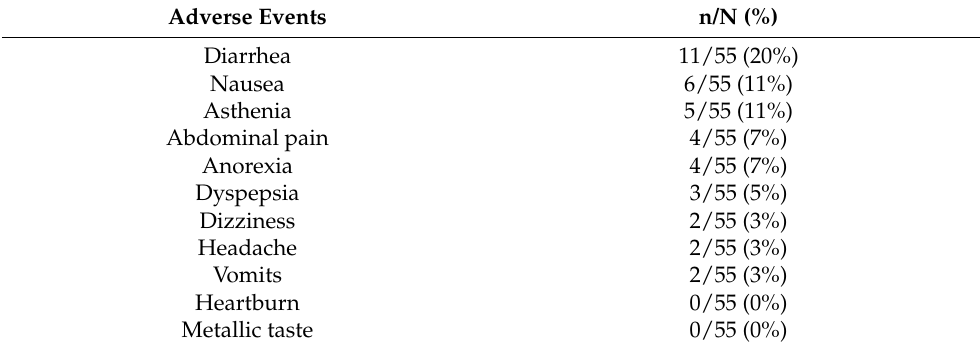
Table 5. Safety with